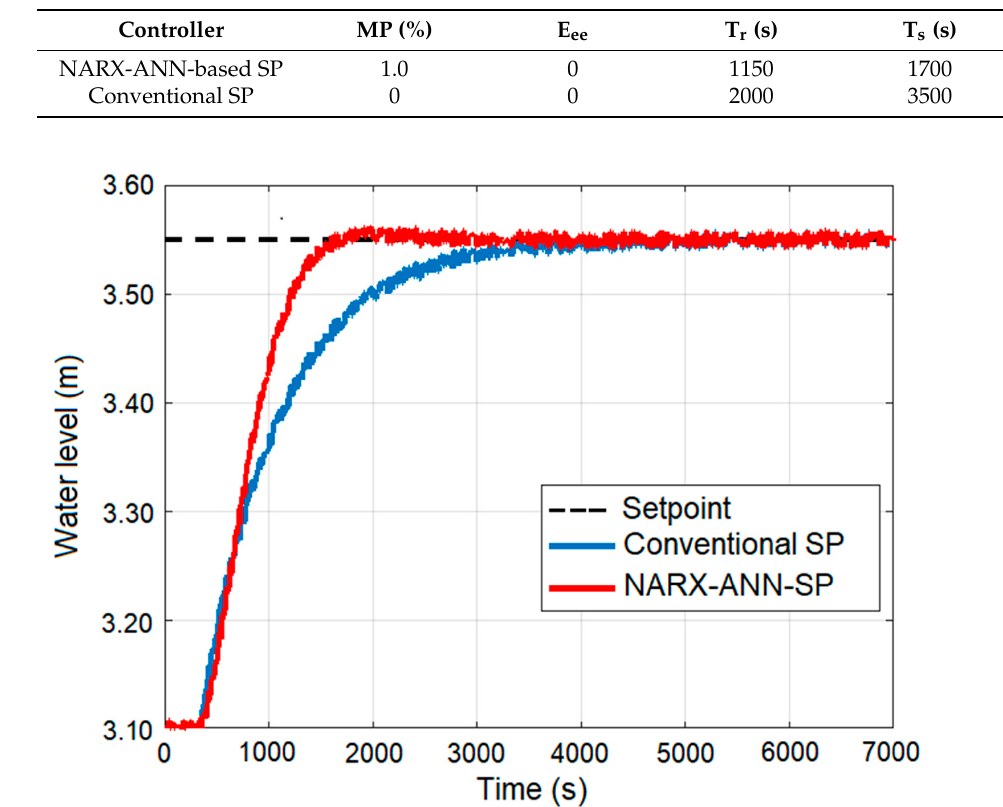
Figure 11. Experimental comparative time responses to a setpoint change of the water distribution control system with both designed controllers.